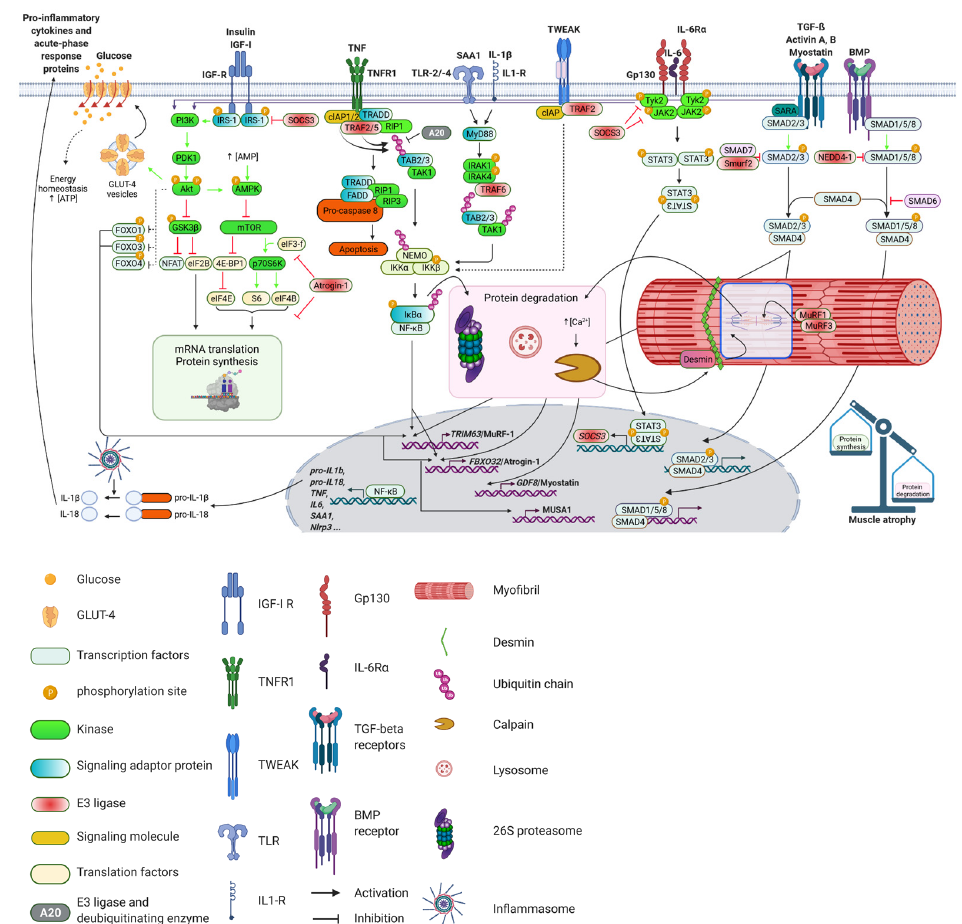
Figure 3. Signaling pathways involved in inflammation-induced skeletal muscle atrophy. BMP R: Bone Morphogenetic Protein (BMP) Receptor; Calp: Calpain; Fn14: Fibroblast Growth Factor-Inducible 14; GP130: Glycoprotein 130; GSK-3 β : Glycogen Synthase Kinase 3 β ; IL-1 β : Interleukin-1 β ; IL-1 R: Interleukin 1 Receptor; IL-6: Interleukin-6; IGF R: Insulin-like Growth Factor (IGF) I Receptor; P: Phosphorylation; MuRF: Muscle RING finger 1; NF- κ B: nuclear factor ‘kappa-light-chain-enhancer’ of activated B-cells; SAA1: Serum Amyloid A1; STAT: Signal Transducer and Activator of Transcription; TGF- β R: Transforming Growth Factor β (TGF- β ) Receptor; TLR: Toll-like Receptor; TNF R: Tumor Necrosis Factor (TNF) Receptor; TWEAK: Tumor Necrosis Factor-Related Weak Inducer of Apoptosis; SMAD: Small Mothers Against Decapentaplegic. For further details, please refer to the text. Created with https://biorender.com/.